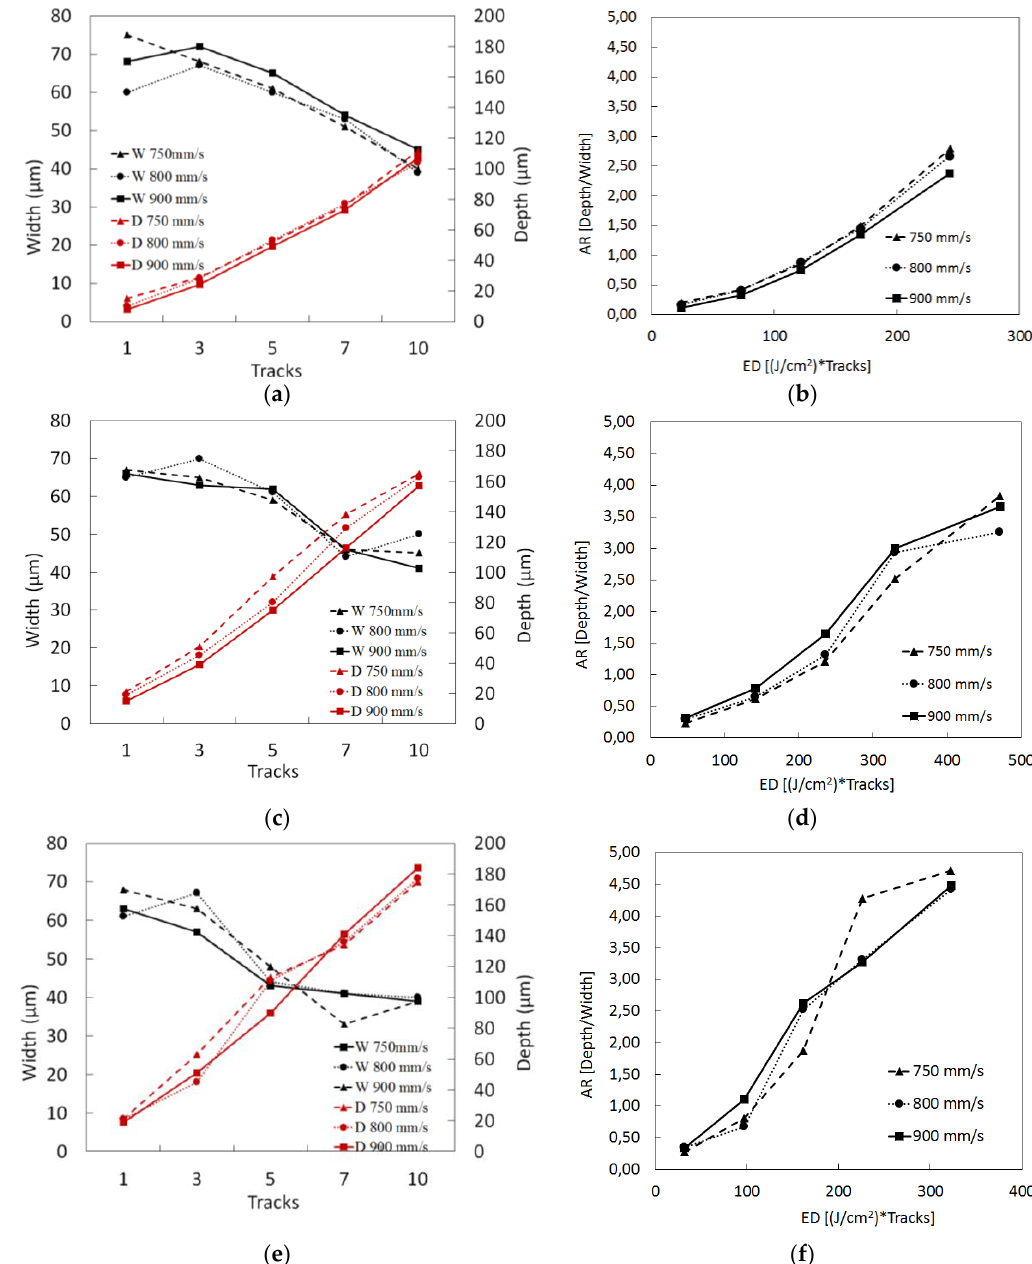
Figure 9. ( a ) Width and depth evolution at 30 kHz. ( b ) The Energy Density (ED) influence on Aspect Ratio (AR) at 30 kHz. ( c ) The width and depth evolution at 50 kHz. ( d ) The ED influence on AR at 50 kHz. ( e ) The width and depth evolution at 70 kHz. ( f ) The ED influence on AR at 70